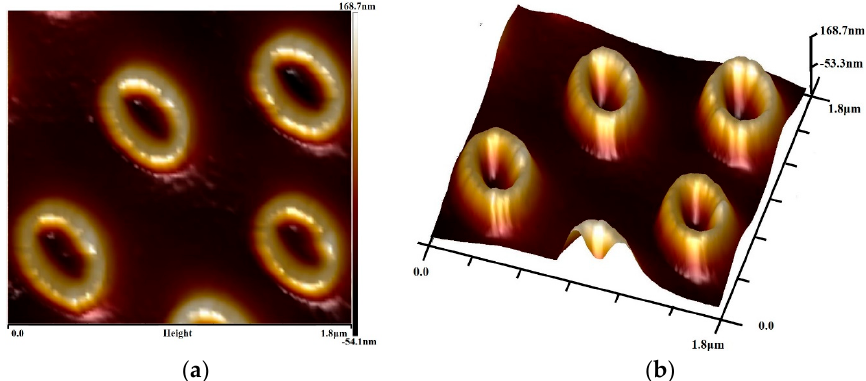
Figure 9. AFM ( a ) 2D and ( b ) 3D images of untreated diatomite.